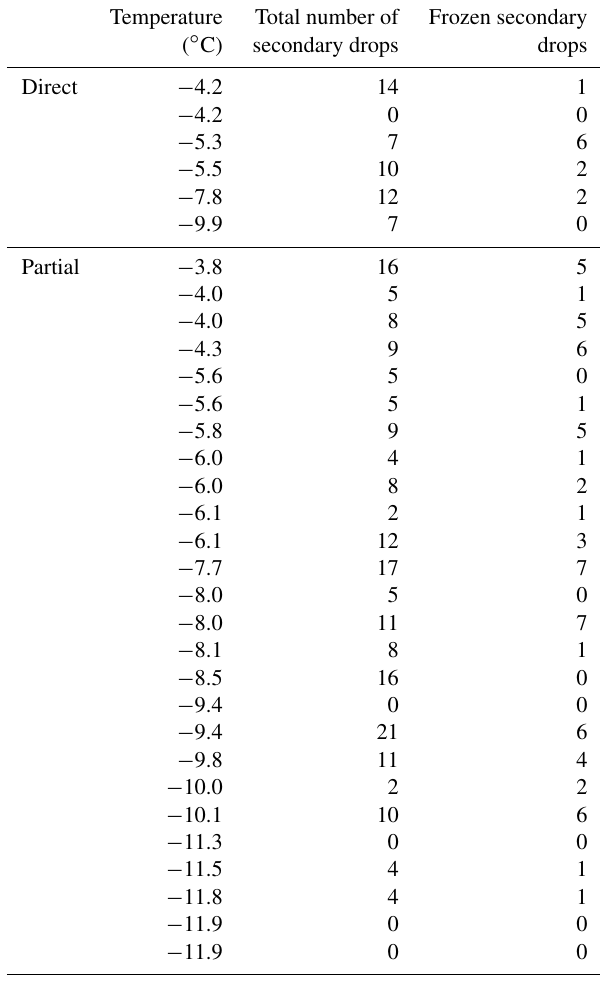
Table A1. Total number of secondary drops and the number of frozen secondary drops for each